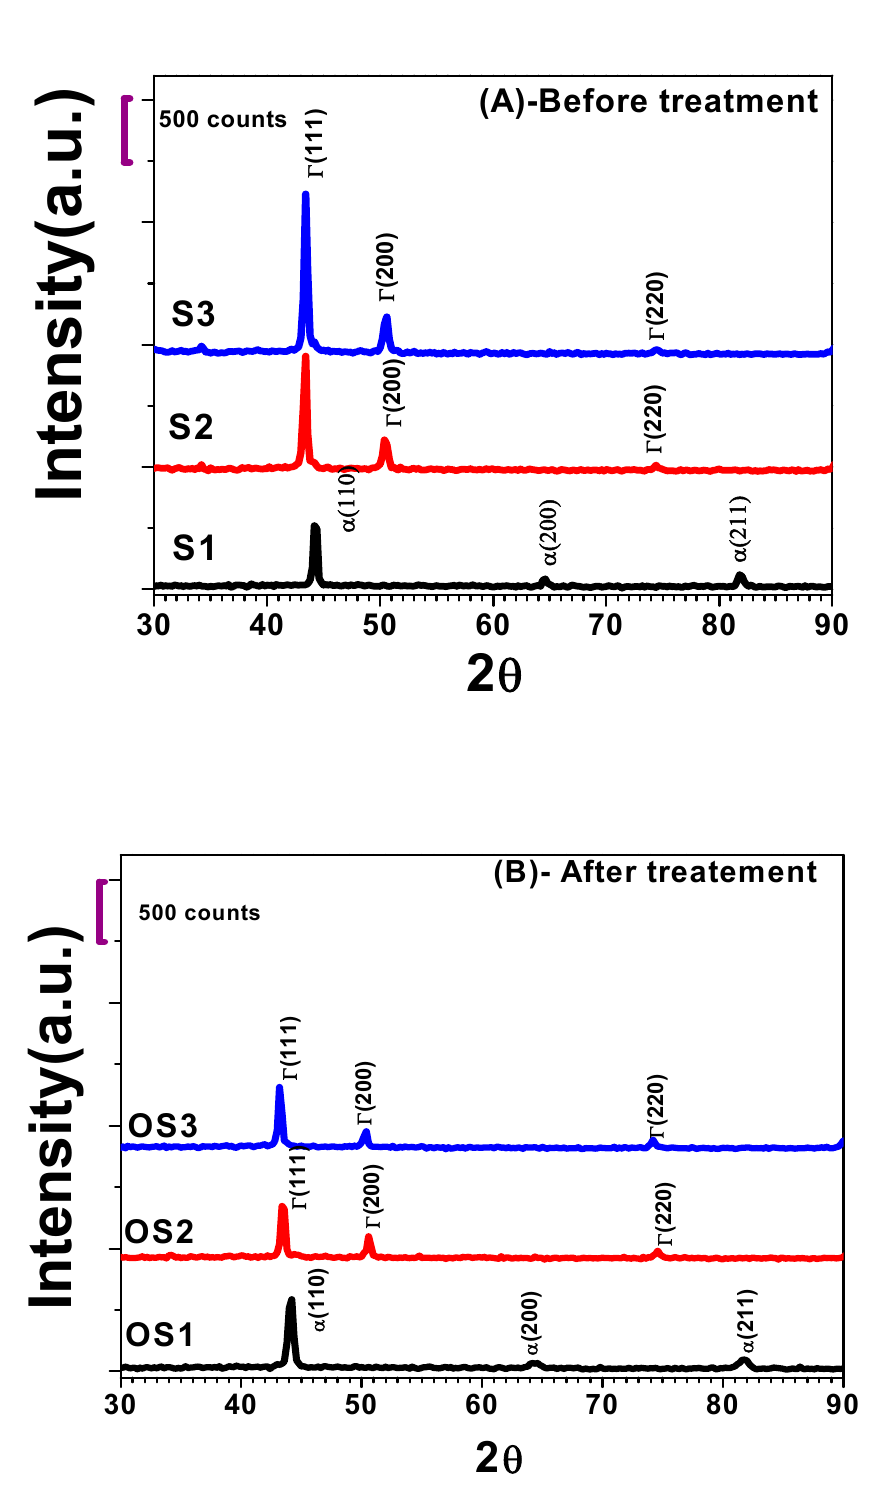
Figure 3. X ‐ ray diffraction analysis for the stainless steel grades ( A ) before and ( B ) after the heat treatment process